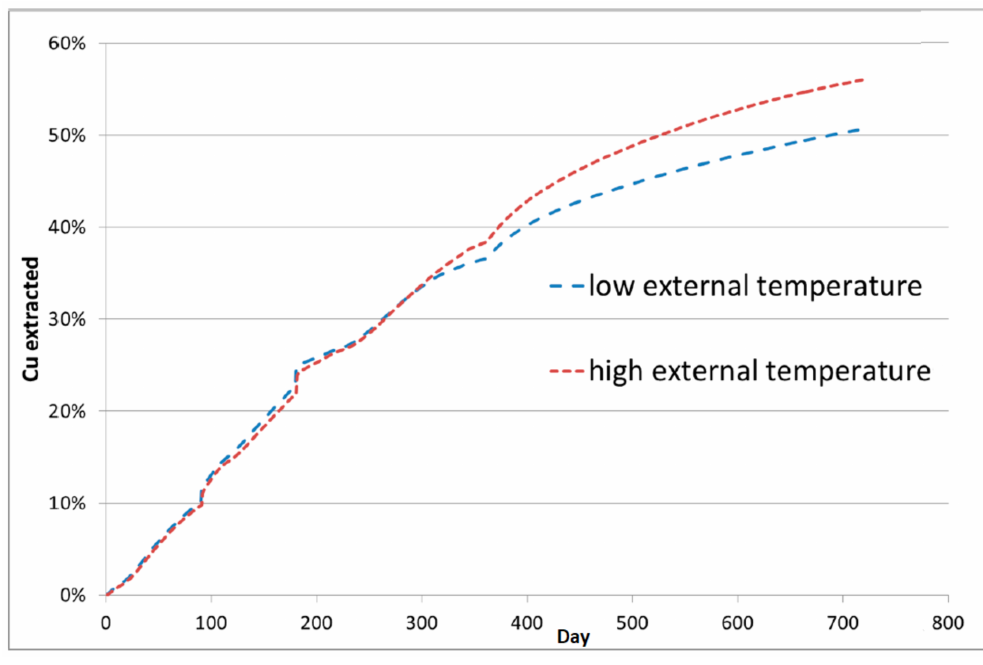
Figure 7. Copper recovery for meteorological data. Minerals 2018 , 8 , 9